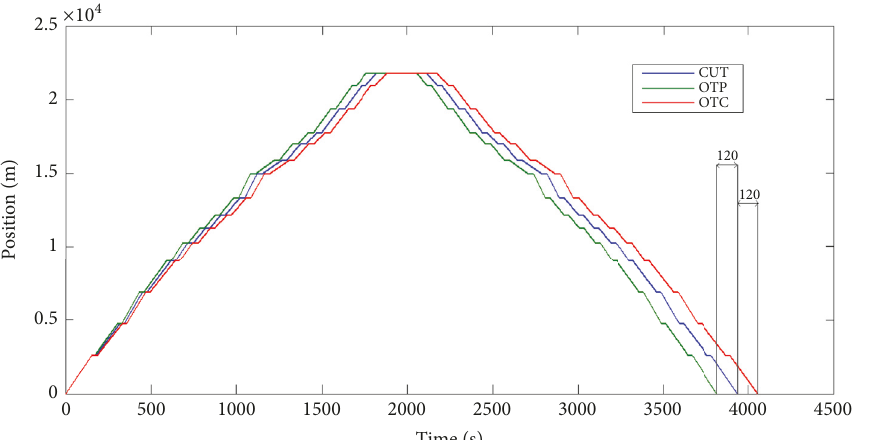
Figure 9: Comparison between the optimized timetable and the current